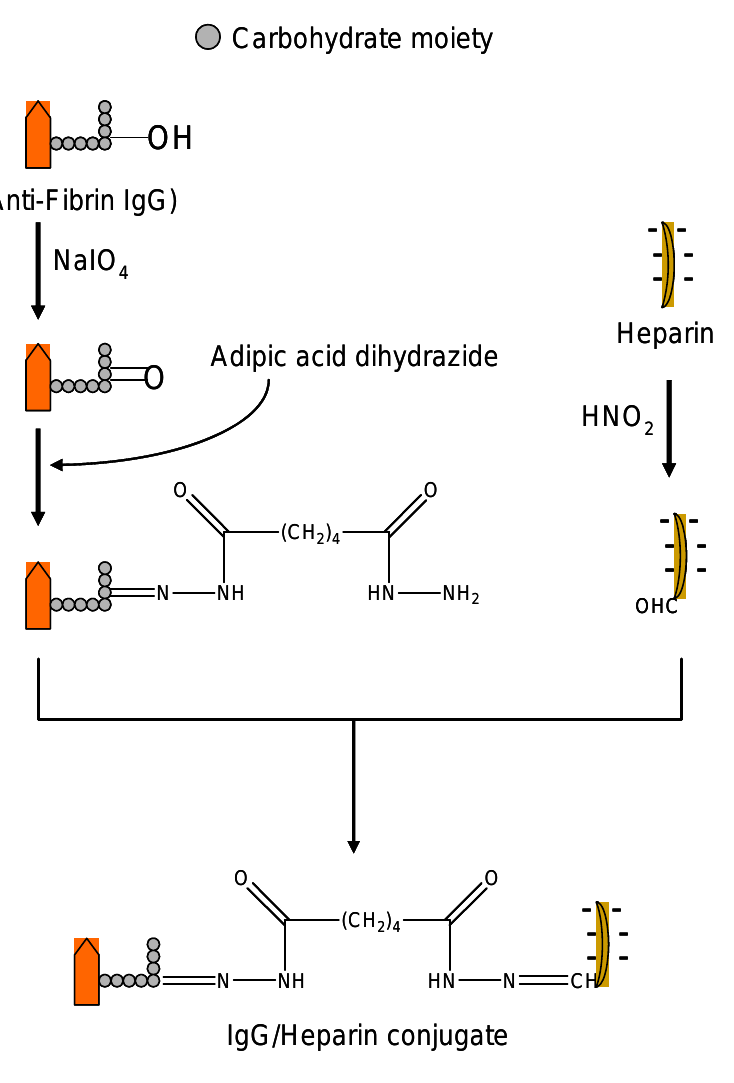
Figure 12. The synthesis of the heparin-antifibrin IgG conjugate (adapted from